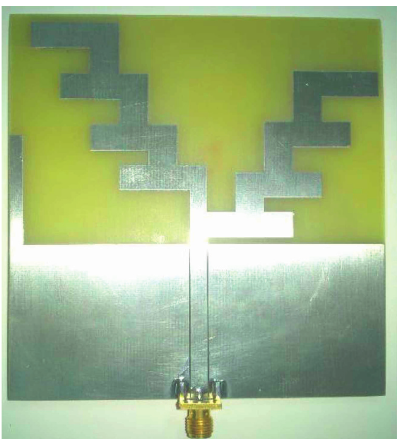
Figure 6: Fabricated prototype of the RFID reader antenna.